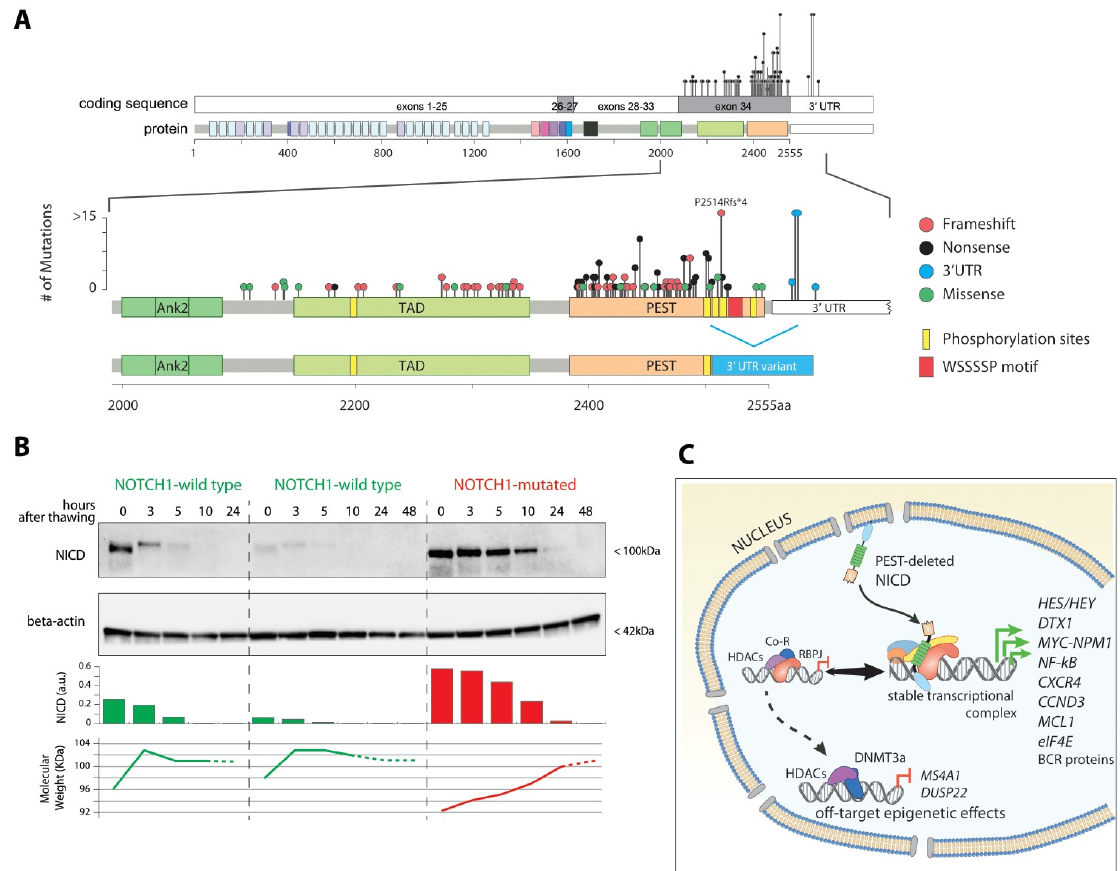
Figure 3. NOTCH1 mutations in CLL. ( A ) In CLL, NOTCH1 mutations almost exclusively affect the c-terminal domain of the protein, specifically exon 34. The most common mutation is c.7514– 7542delCT, p.P2514Rfs*4, which truncates the phosphorylation and ubiquitination (WSSSSP) sites. Other mutations within the coding sequence are mostly frameshift (red) and nonsense (black) truncating events scattered across exon 34, leading to the same outcome. The 3′UTR mutations (blue) lead to an alternate splicing event, mostly with a cryptic site around Q2503, which leads to an alternate transcript again lacking the main phosphodegron. Missense mutations (green) are rare events, usually private polymorphisms. ( B ) Prototypic immunoblot detection of NICD in primary CLL samples. Wild-type NICD is promptly phosphorylated and ubiquitinated, with an increase in molecular weight, degradedation within hours. Mutated NICD (p.2514R*fs4) displays prolonged stability. Dashed lines represent a hypothetical trajectory since protein levels were undetectable. Samples were thawed cryopreserved PBMC from EDTA-stabilized peripheral blood samples. Densitometry and molecular weight calculations were performed with ImageLab (Bio-Rad). ( C ) Schematic representation of the effect of NOTCH1 mutations. Superstable NICD skews the balance of the RBP-Jκ complex toward transcriptional activation, enhancing gene transcription of multiple genes. Unbound repression proteins, mostly epigenetic modifiers such as histone deacetylases (HDACs) and methyltransferases (DNMT3a) relocate to other targets. Original blots see Supplementary File S1.